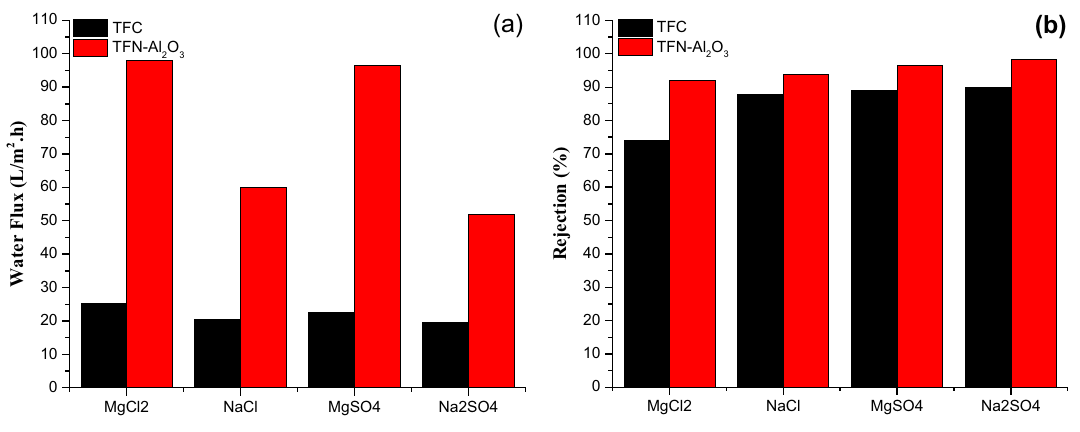
Figure 14. Water flux ( a ) and Salt rejection ( b ) of 0.3 wt.% TFN-Al 2 O 3